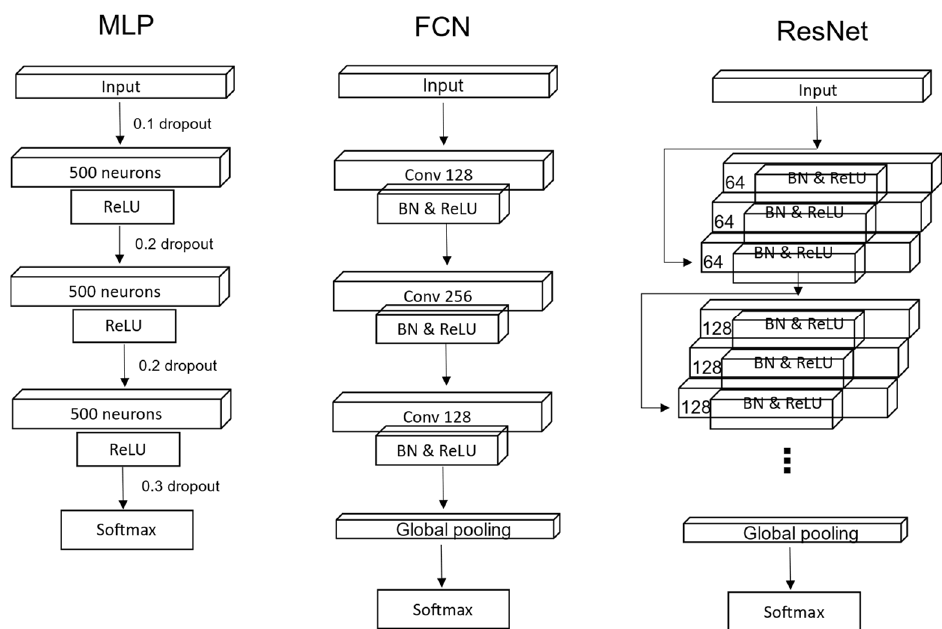
Figure 1 . The generalization of network architectures of the different neural networks applied to classify time series data.